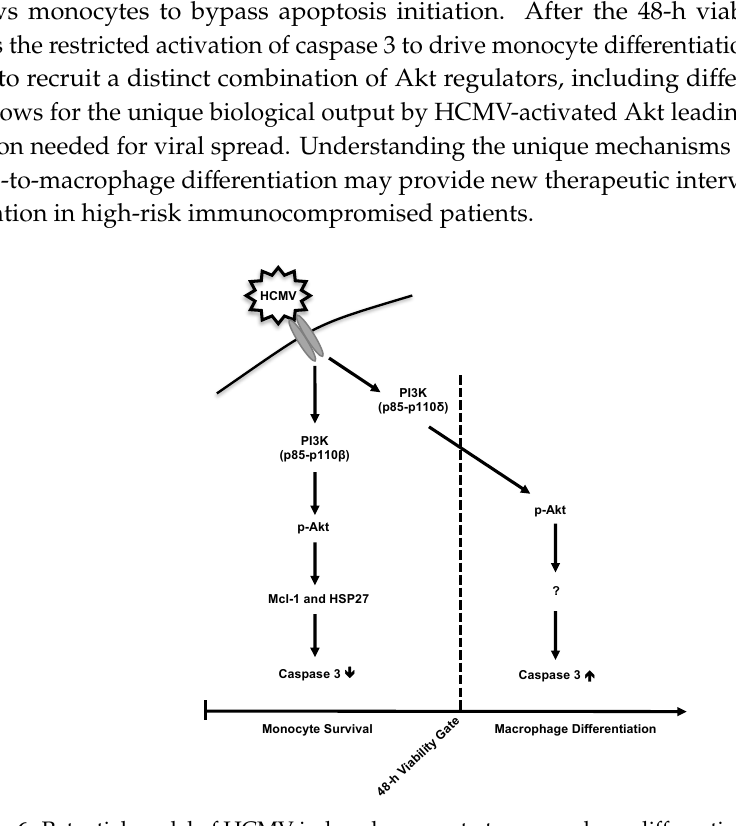
Figure 6. Potential model of HCMV-induced monocyte-to-macrophage differentiation. HCMV infection rapidly triggers PI3K-p110 β signaling leading to a predominantly S473 phosphorylation of Akt and the upregulation of Mcl-1 and HSP27. Subsequently, the intrinsic biological programming of monocytes to activate caspase 3 is blocked by HCMV, allowing for infected monocytes to survive through the 48-h viability gate. Concomitant to PI3K-p110 β activation, HCMV stimulates PI3K-p110 δ leading to a distinct pool of activated Akt phosphorylated at S473 and T308 after 48 h. We hypothesize that this separate pool of Akt targets an unknown factor required for the controlled activation of caspase 3 after the 48-h viability gate in order to drive the unique M1 / M2 macrophage differentiation of infected